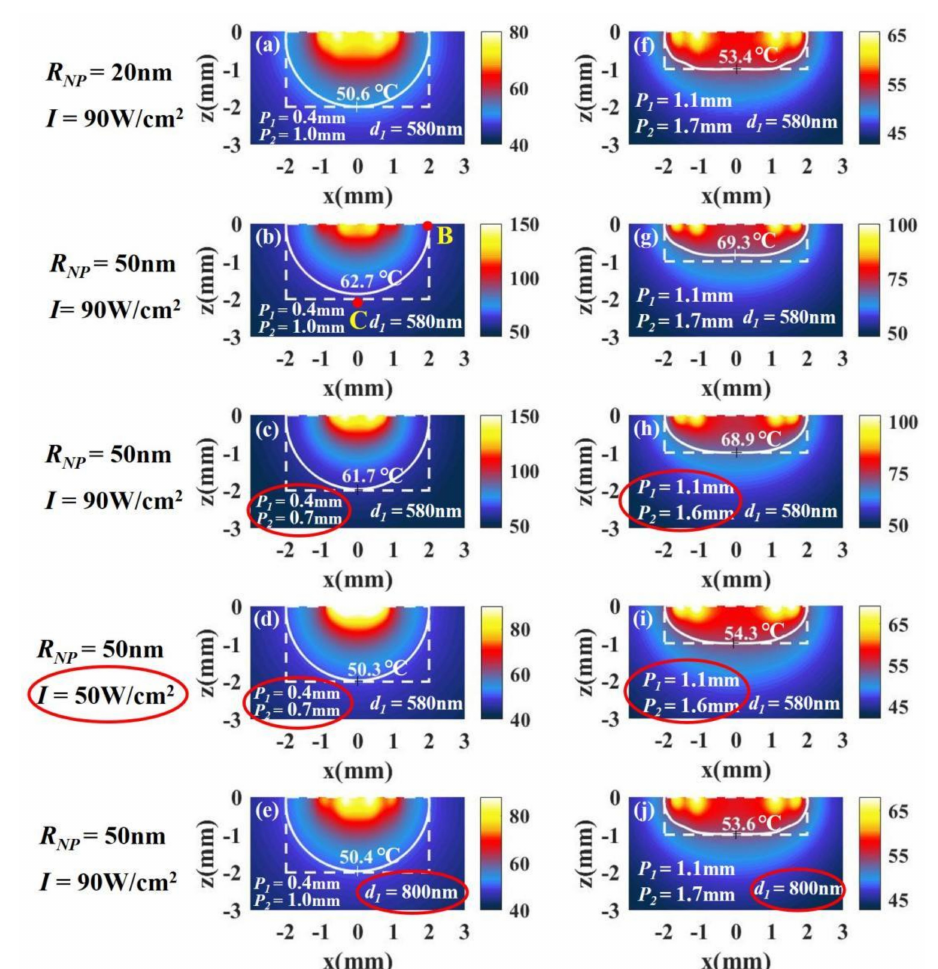
Figure 10. The temperature distributions of a tumor with ( a – e ) a large aspect ratio, z/ RT = 1 ( R T = 2 mm, z = 2 mm), and ( h – j ) a small aspect ratio, z/ RT = 0.5 ( R T = 2 mm, z = 1 mm). The radius of the nanoparticles is 20 nm in ( a ) and 50 nm in ( b ), and the other parameters used in the calculations in ( a ) and ( b ) are the same. To improve the temperature distribution in ( b ), we can change P 1 and P 2 in ( c ). We can reduce the temperature by reducing the light intensity in ( d ). We can also improve the temperature distribution by changing the distance between the particles in ( e ). Similar results can be obtained in the case of small aspect ratios in ( f – j